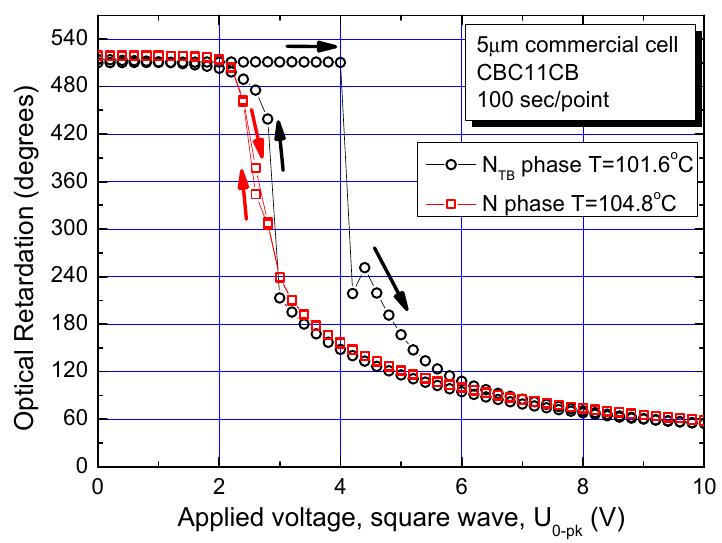
Figure 6. Plot of the ‘Optical Retardation’ (OPR) vs. applied voltage applied across a planar-aligned cell for temperatures in both N and N TB phases. Material used is M1 with ∆ ε > 0. Black arrows correspond to the field increasing and decreasing in the N TB phase. Red squares correspond to the data in the N phase.